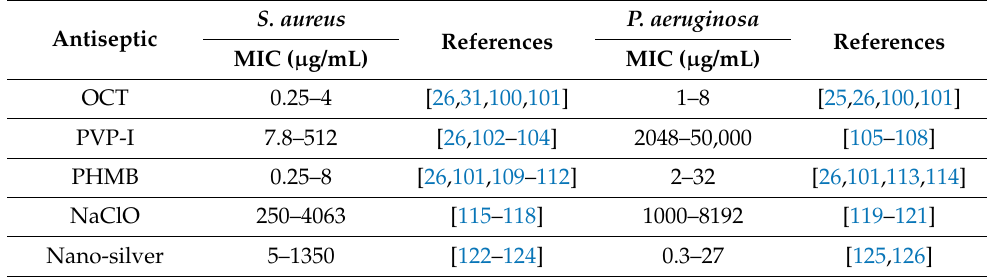
Table 1. Minimal inhibitory concentration (MIC) values for selected antiseptics against Staphylococcus aureus and Pseudomonas aeruginosa